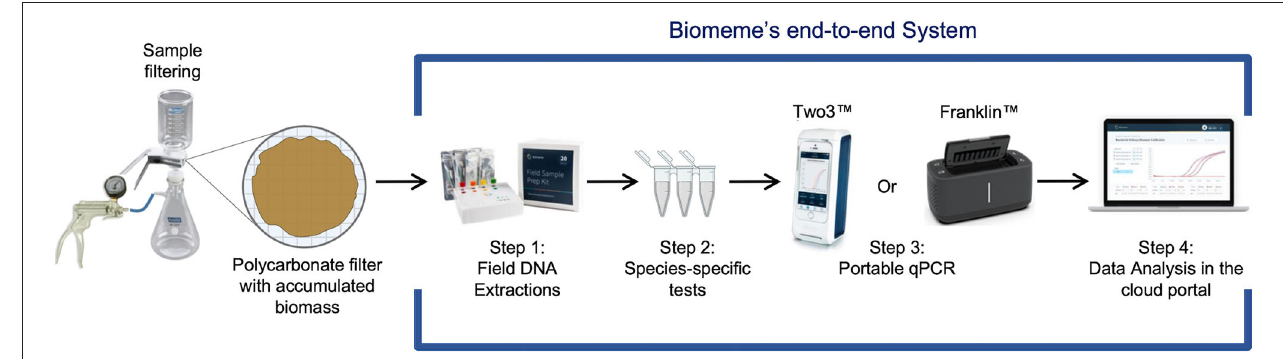
FIGURE 3 | Summary of Biomeme qPCR workflow. Water is membrane-filtered then (1) DNA is extracted using the field DNA sample prep kit; (2) Enterococcus qPCR assays are set up in reagent strips; (3) qPCR assays are run on the smartphone-controlled handheld thermocycler; (4) data is retrieved for analyses via the cloud portal or exported as raw data from the